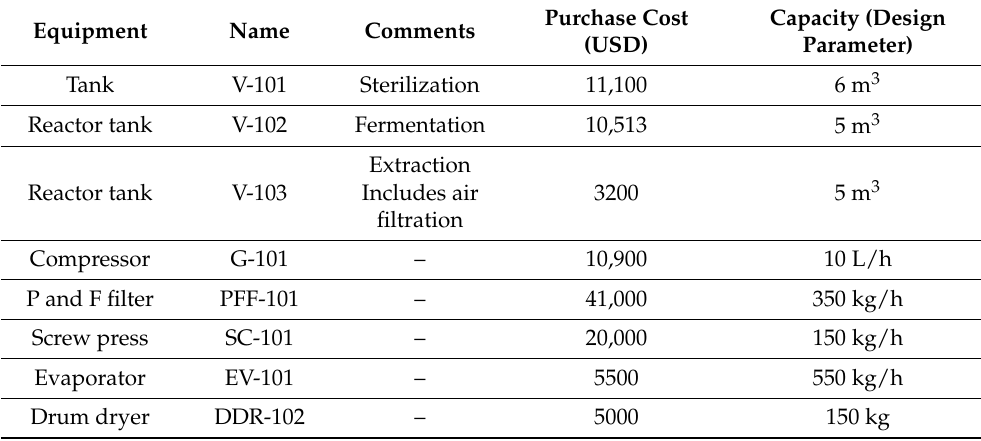
Table 3. Main equipment to produce SL crystals by using SSF, as modelled in Figure 1.